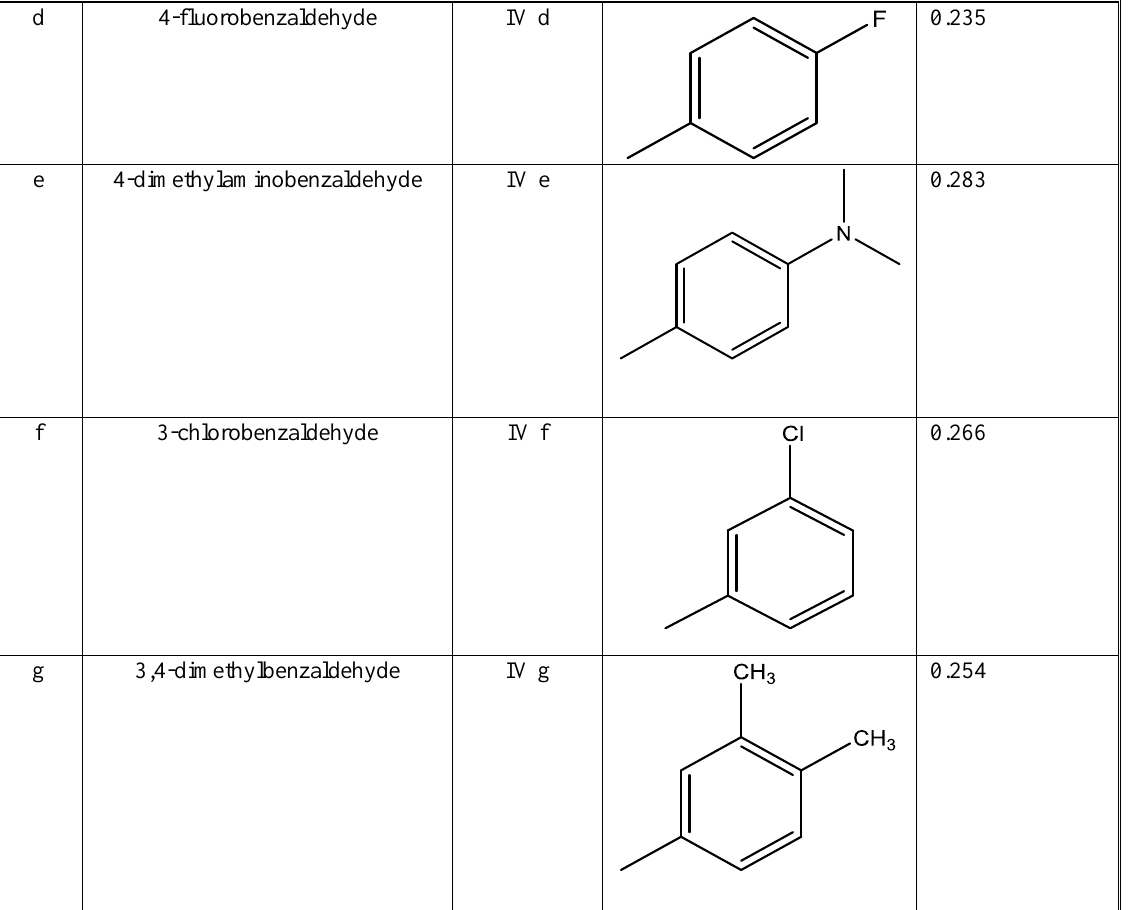
2-(N-(2,3-dimethylphenyl)-2-((2-(4-nitrophenyl)- 4-oxothiazolidin-3-yl)amino)acetamido)benzoic acid (IVb) FTIR: 3236 cm -1 (N-H hydrazine); 1778 cm - 1 (C=O thiazolidinone); 1728 cm -1 (C=O amide); 1681cm -1 (C=O of carboxylic acid) ; 1346 cm -1 (NO 2 stretching) and 1238cm-1(C-O). 1 HNMR (300 MHz, : DMSOd 6 ) H: 3.7-3.9 (2H, d, CH 2 thiazolidinone);4.1